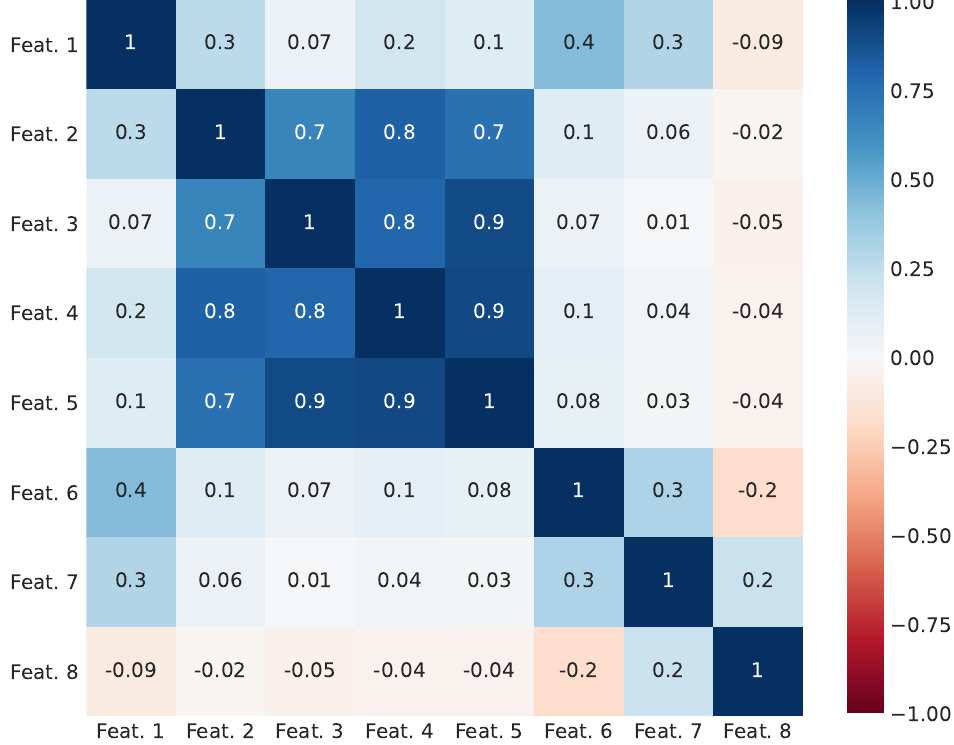
Figure 5. Heatmap presenting linear correlation (values of PPC) between features in the training